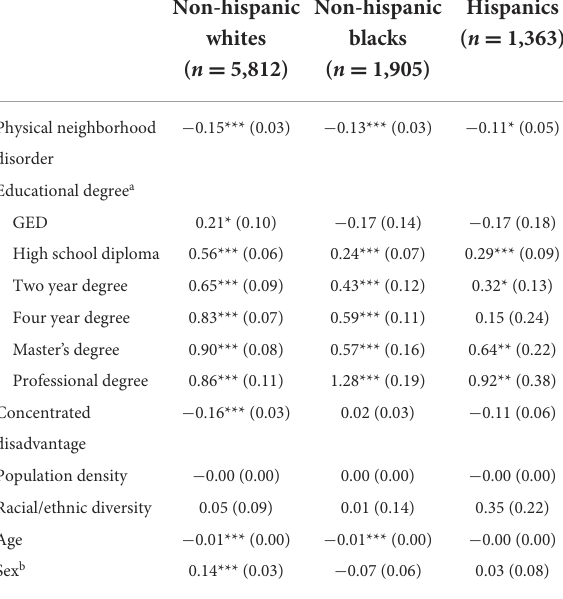
TABLE 2 Weighted linear regressions predicting perceived neighborhood safety by neighborhood physical disorder, [coefficient (SE)].